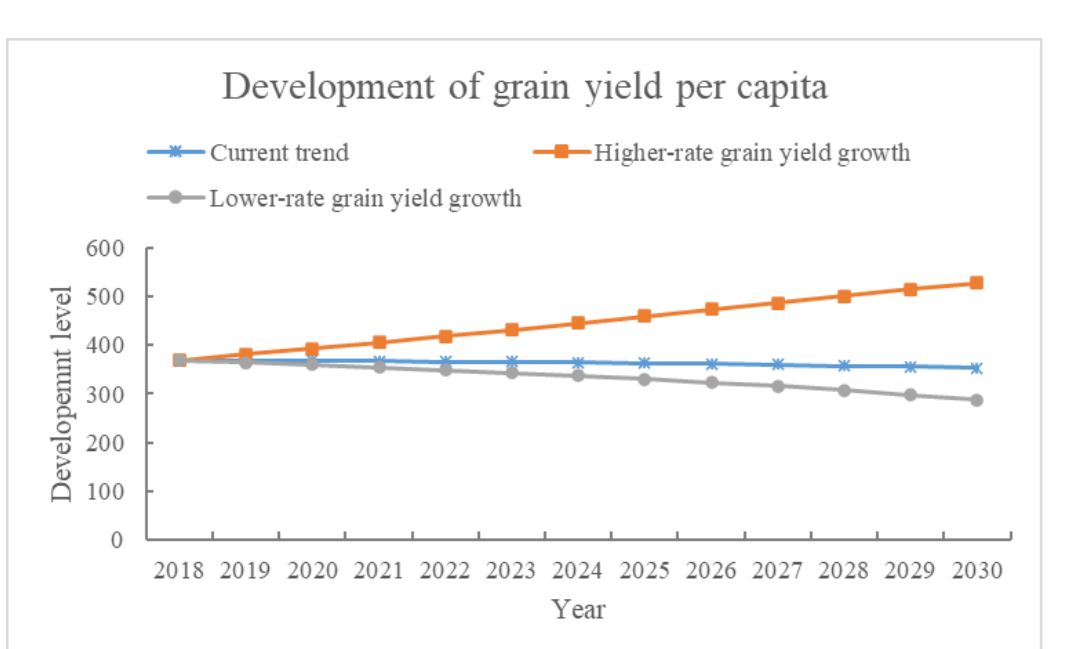
Figure 5. Development of grain yield per capita under three scenarios.